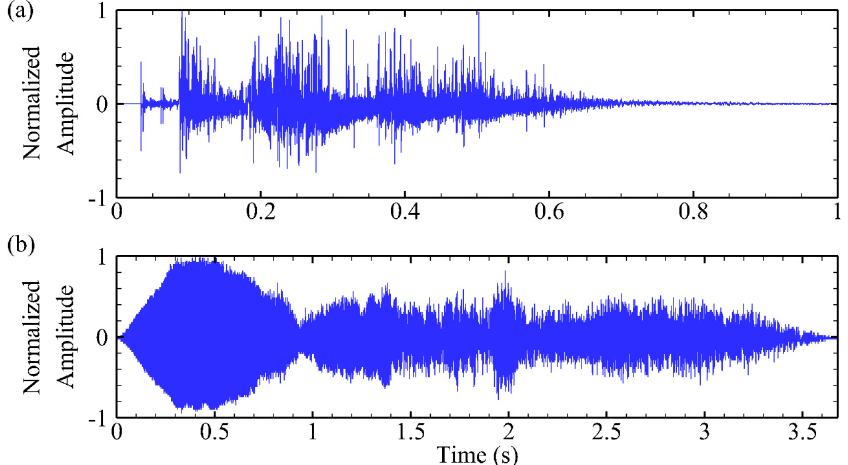
Figure 6. Waveforms used for tank testing. ( a ) Underwater explosion; ( b ) whale